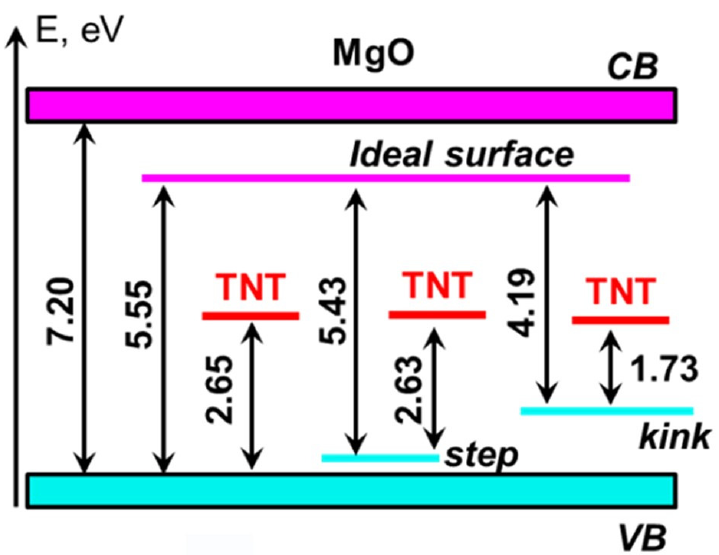
Figure 6. A diagram showing the relative energies of localized electronic states corresponding to the TNT molecule atop of the step and kink defects at the MgO (001) surface versus the defect-free bulk and surface MgO (001) band gaps.